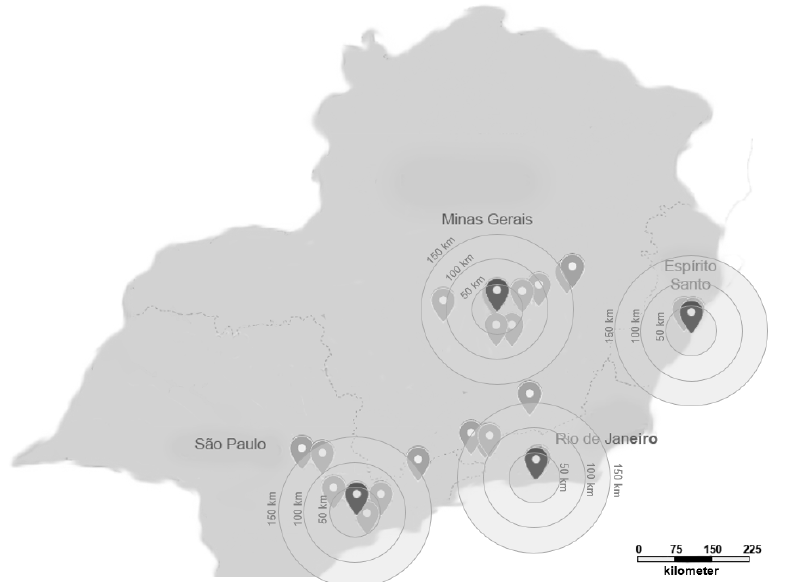
Figure 2. Map of Brazil’s Southeast Region with the location of the steel industries and radial distances of the capital